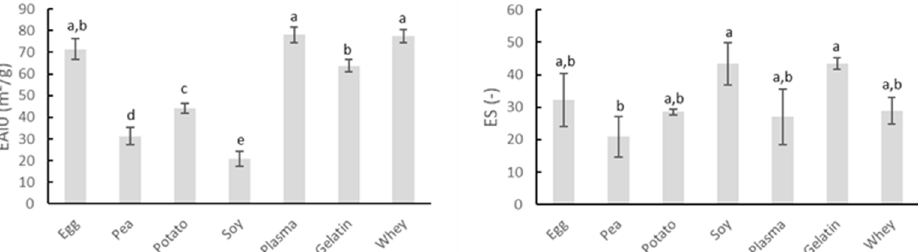
Figure 2. Comparison of emulsifying activity index immediately after emulsion formation (EAI0, m 2 /g) and emulsion stability (ES) of several protein sources. Mean values and standard deviations are presented (n = 4). Letters a–e: different letters indicate significant differences ( p < 0.05) between different proteins.